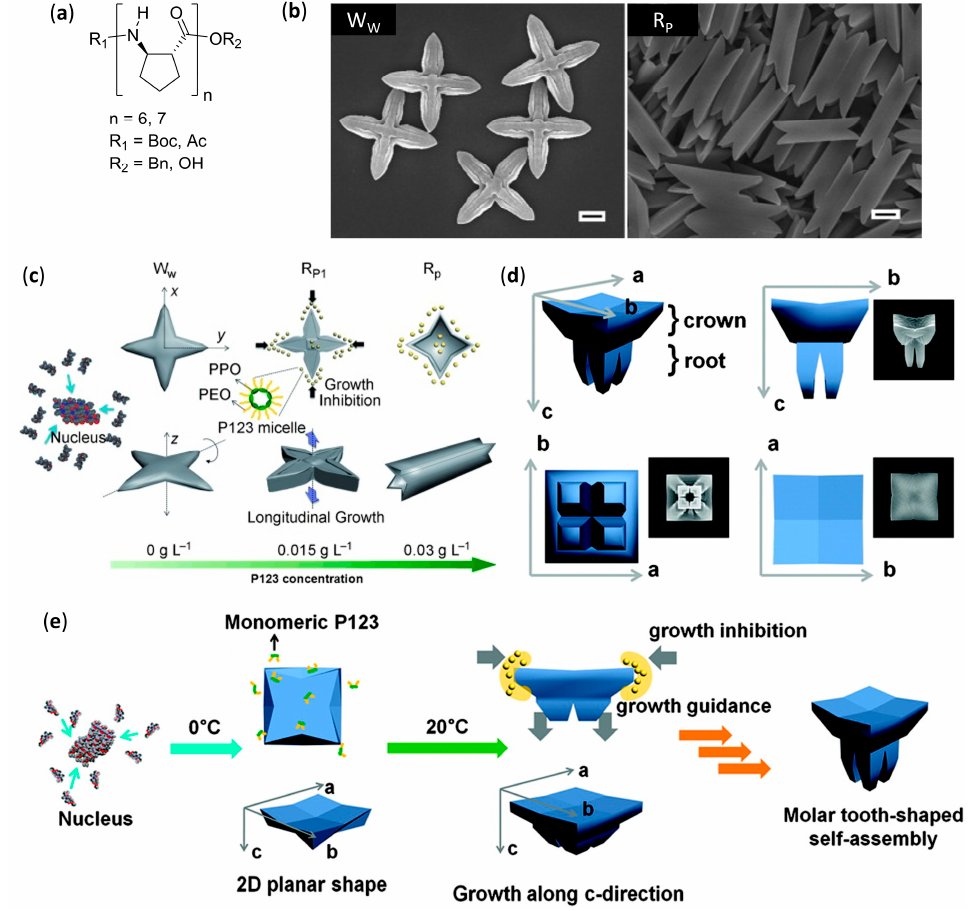
Figure 8. ( a ) General structure of trans -ACPC oligomers investigated (both S , S and R , R absolute stereochemistries were employed) (Refs. [131–138]); ( b ) SEM images of structures self-assembled from Boc-ACPC 7 -OBn in distilled water (W W ) and in a 0.03 g L − 1 aqueous solution of P123 (R P ) (scale